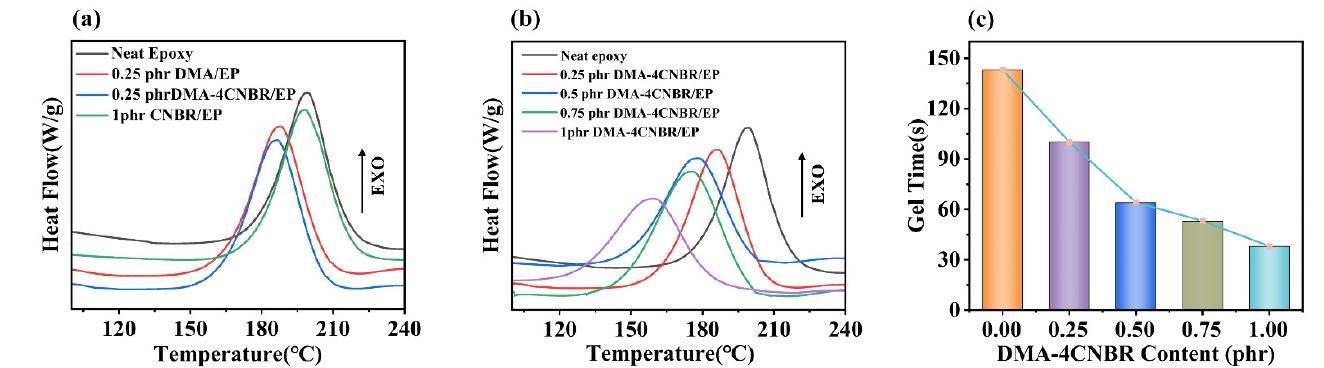
Figure 2. ( a , b ) DSC curves for different coatings at 10 °C/min ( c ) Gelling time of different proportions of DMA-4CNBR-modified epoxy coating.